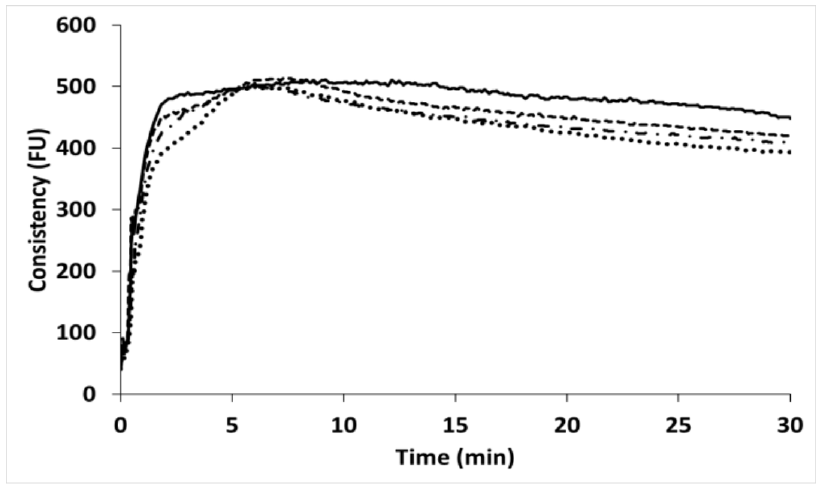
Figure 2. Mixing properties of wheat (solid line), and increasing replacement level of cricket powder (5%: dash line; 10%: dash–dotted line; 20%: dotted line). FU—Farinograph